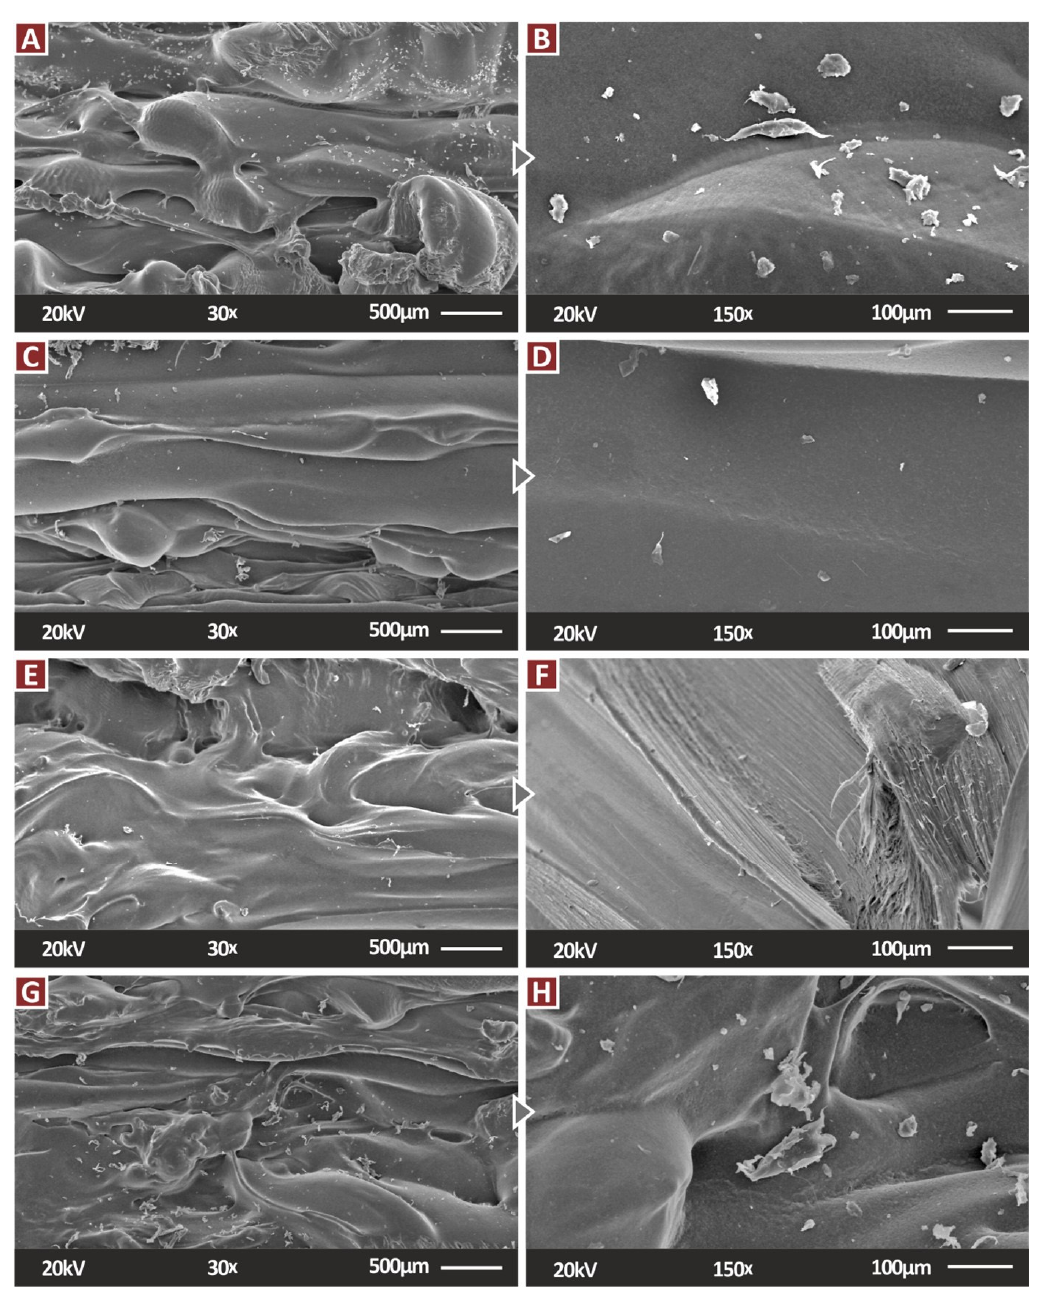
Figure 9. 3D-printed tensile test samples (randomly selected) SEM images of their side surfaces for the composites prepared herein: ( A ) 0.5 wt.% at 30 × magnification, ( B ) 0.5 wt.% at 150 × magnification, ( C ) 2.5 wt.% at 30 × magnification, ( D ) 2.5 wt.% at 150 × magnification, ( E ) 5 wt.% at 30 × magnification, ( F ) 5 wt.% at 150 × magnification, ( G ) 10 wt.% at 30 × magnification, and ( H ) 10 wt.% at 150 ×